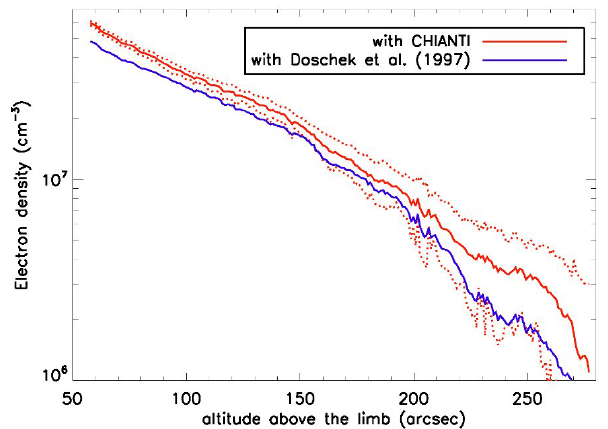
Fig. 2. Value of the non-thermal velocity ξ(r 0 ) for r 0 − R (cid:12) ≈ 60 00 and r − R (cid:12) varying between 60 00 and 270 00 (see Eq. 5). The dotted lines denote the theoretical error bars.